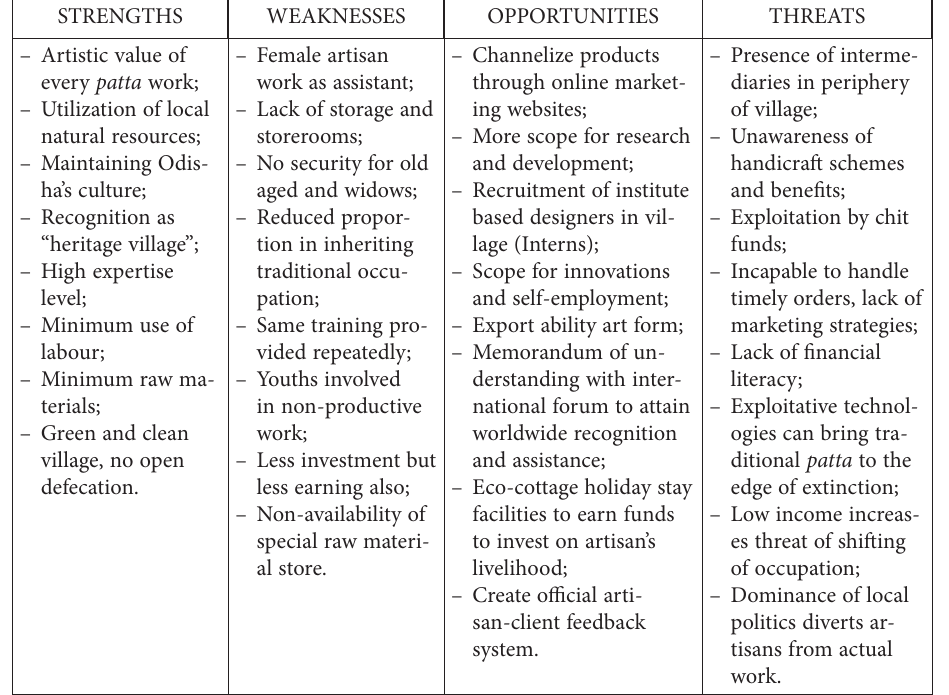
Table 5. SWOT analysis (source: created by authors) STRENGTHS